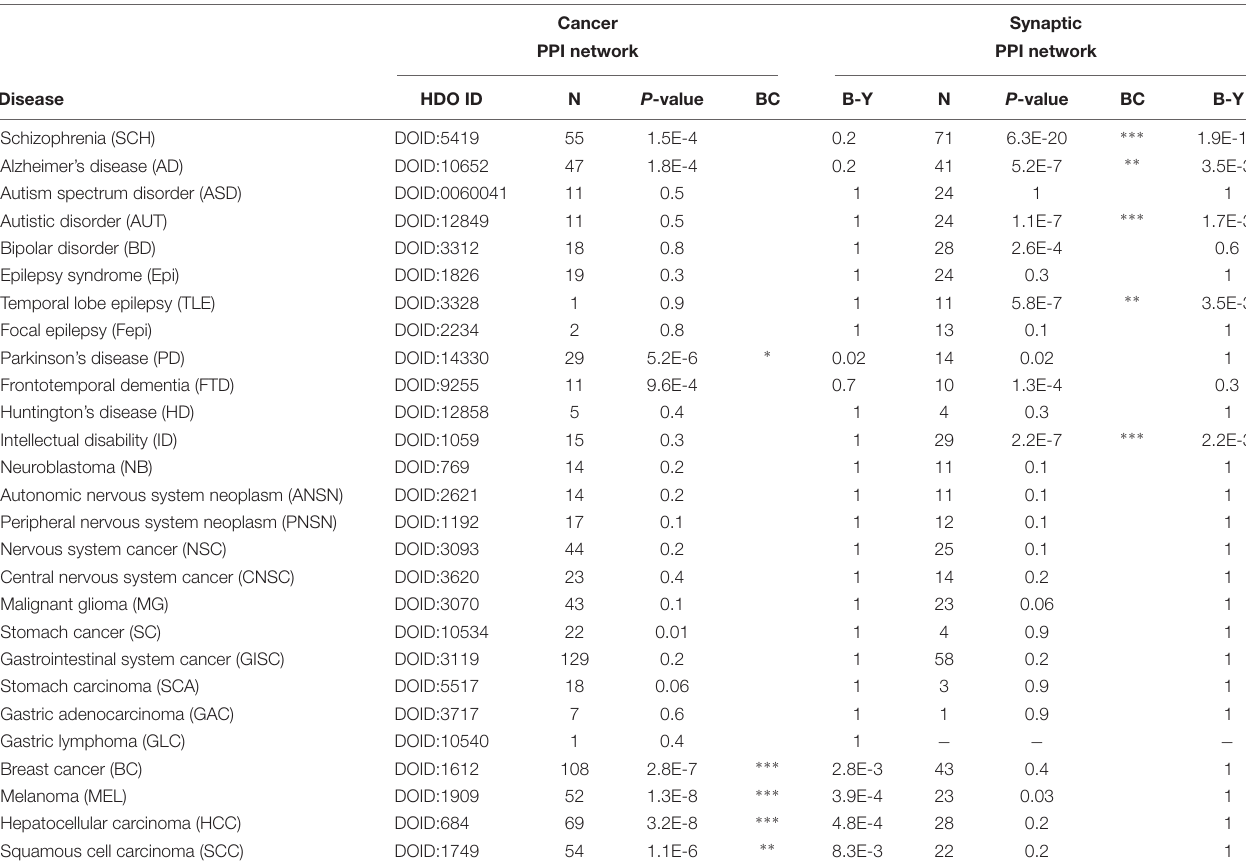
TABLE 3 | Disease enrichment values for p140Cap cancer and synaptic PPI networks.